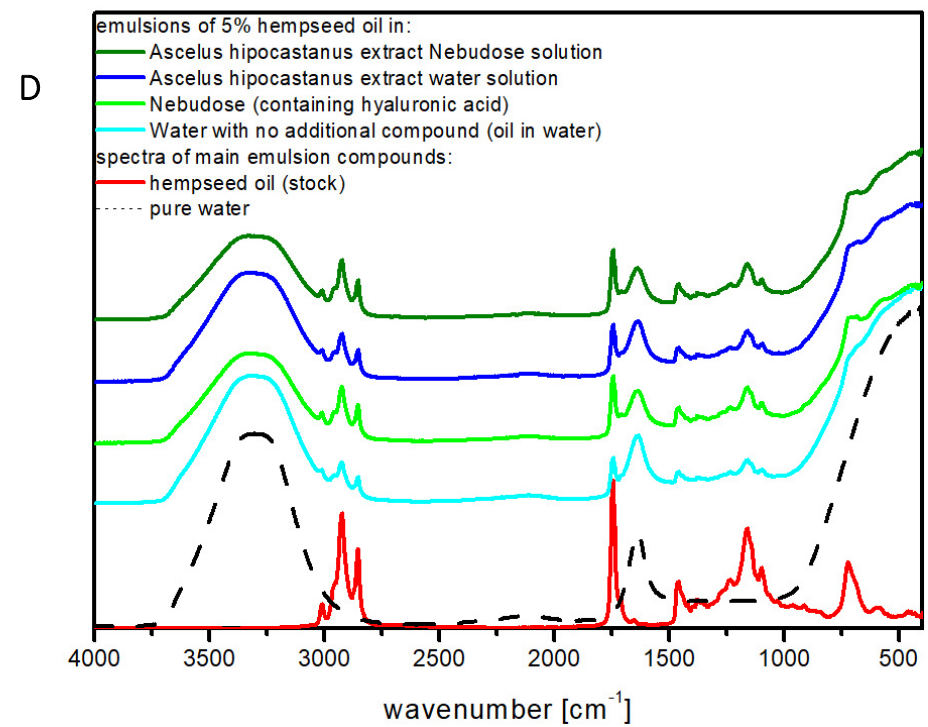
Figure 7. Molecular structures of the selected AHE main components: ( A ) esculin, ( B ) β -aescin, ( C ) (-)-epicatechin [38,39]; ( D ) FTIR spectra of water–oil emulsions for 5% of oil content (24 h after sonication).